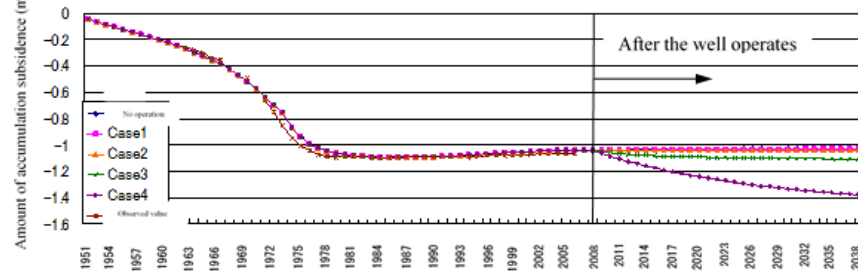
Figure 5. The yearly change of amount of accumulation subsidence in the vicinity of Jushiyama observation